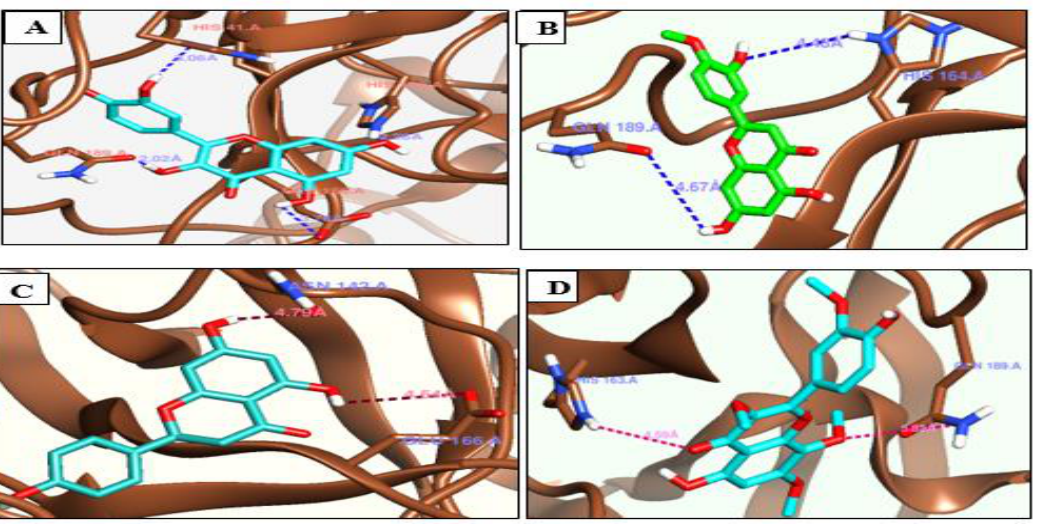
Figure 4. (A) Molecular docking of quercetin interacted with COVID-19 main protease enzyme. (B) Molecular docking of hesperetin. (C) Molecular docking of naringenin. (D) Molecular docking of ternatin.